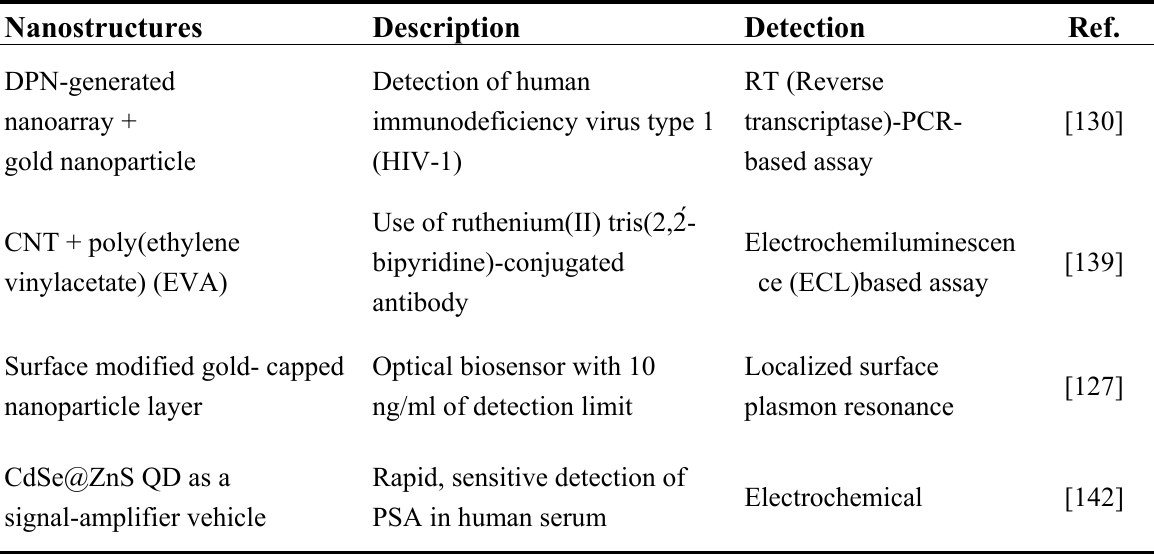
Table 5. Detection of antibody-antigen interaction at the nanoscale.